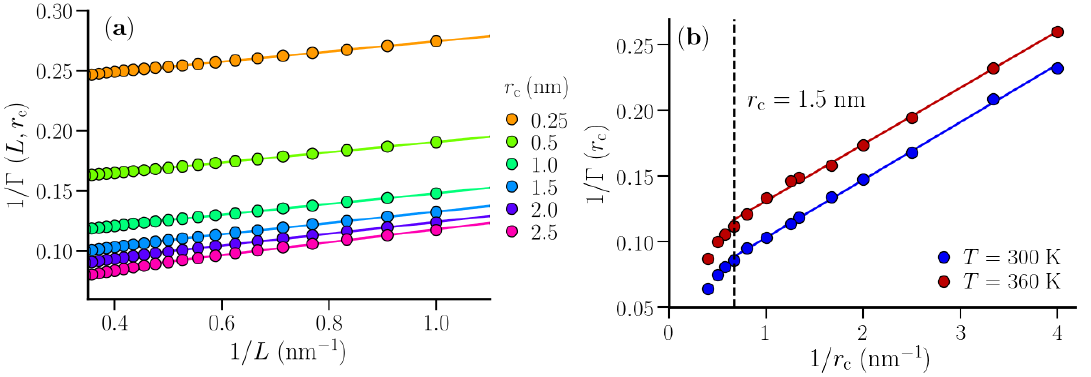
Figure 3. ( a ) 1/ Γ ( L , r c ) profiles for the cylindrical shells with radius r c in SPC/E water at T = 300 K, as a function of 1/ L . The lines are linear fits to the data in the range L = 1 - 2 nm. ( b ) 1/ Γ ( r c ) for the cylindrical shells as a function of 1/ r c at T = 300 K, 360 K. The lines are linear fits to the data in the range r c < 1.5